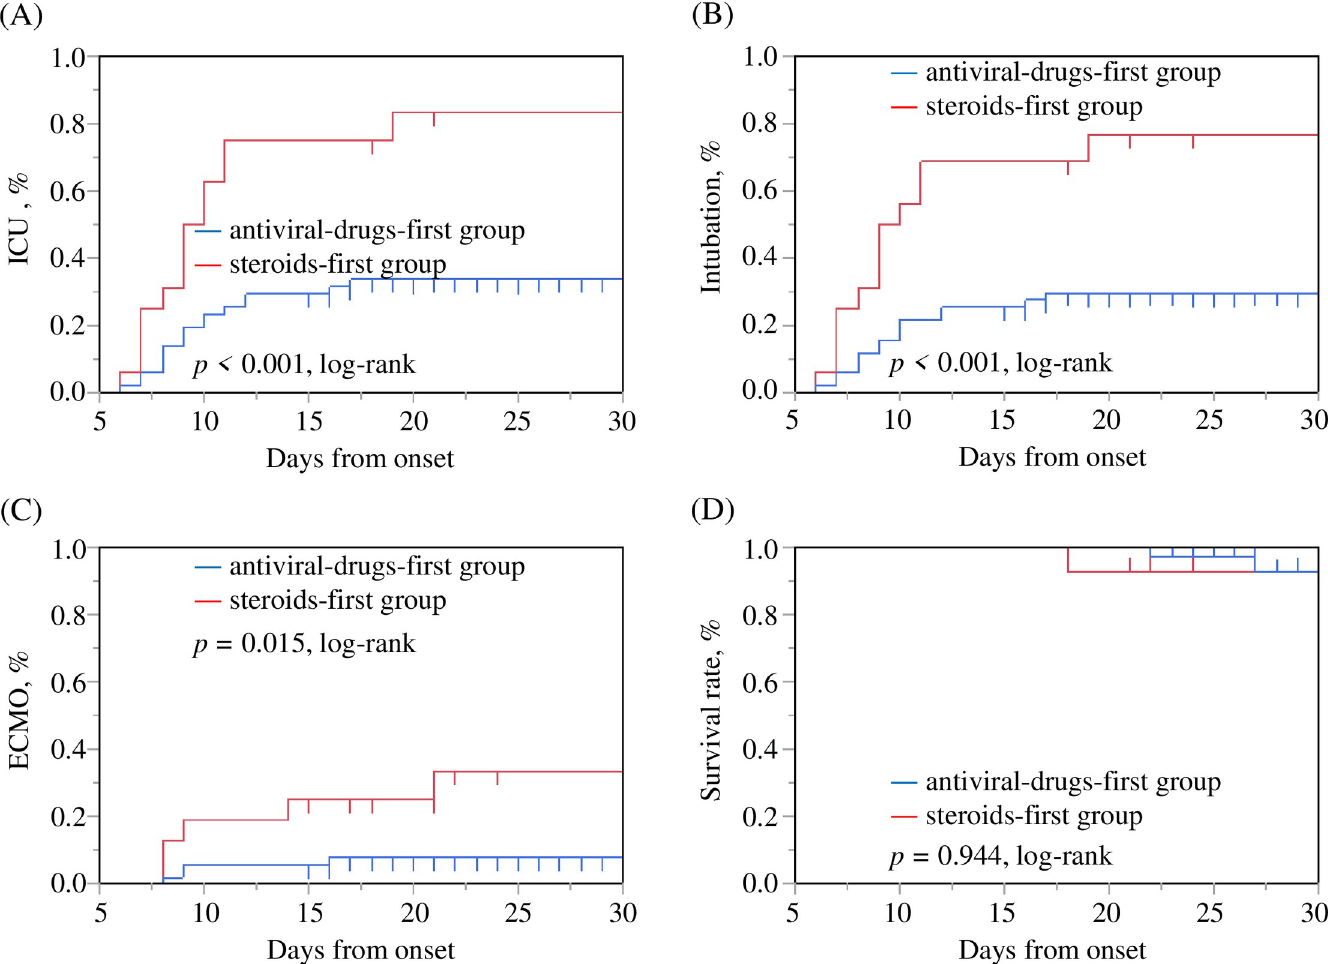
Fig 2. Rate of ICU admission, intubation, ECMO induction, and mortality according to group. The rate of ICU admission, intubation, ECMO induction were poorer in patients of the steroids-first group than in those the antiviral-drugs-first group ( p < 0.001, p < 0.001 and p = 0.015, respectively, log-rank test). ECMO, Extracorporeal membrane oxygenation. ICU, Intensive care